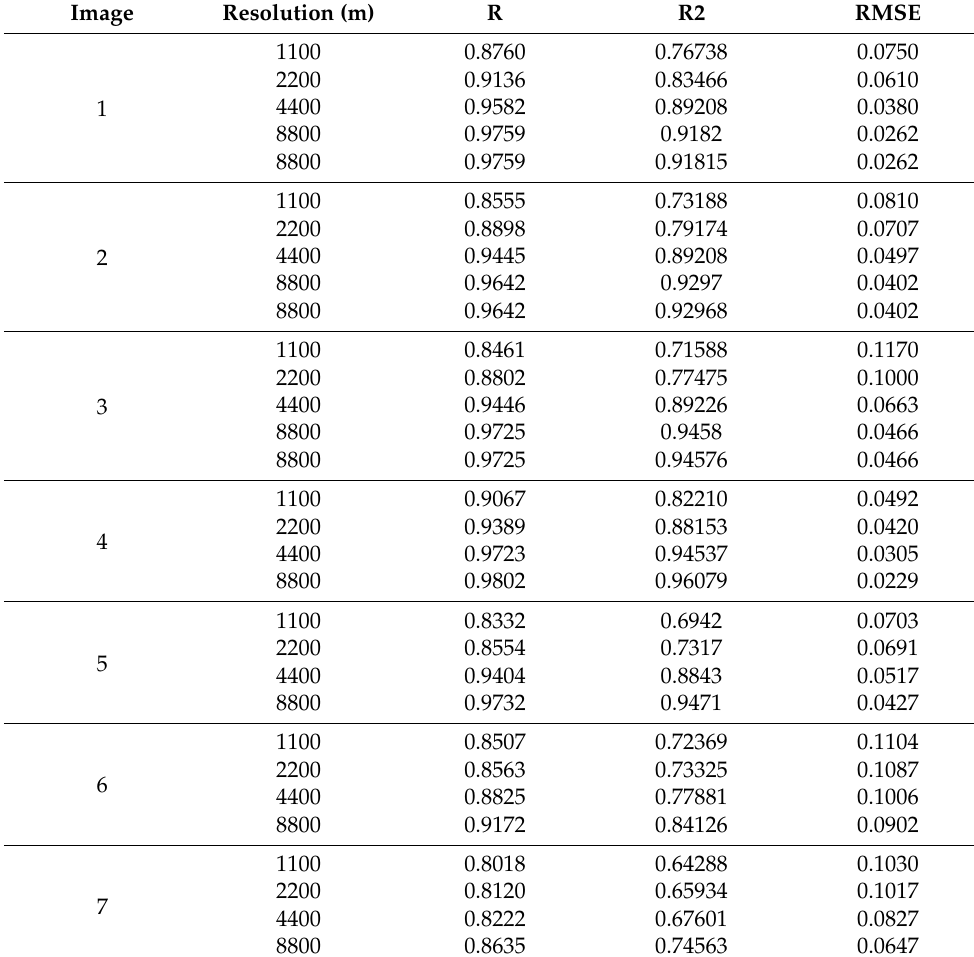
Table 2. The validation results of the subpixel snow mapping in this work.